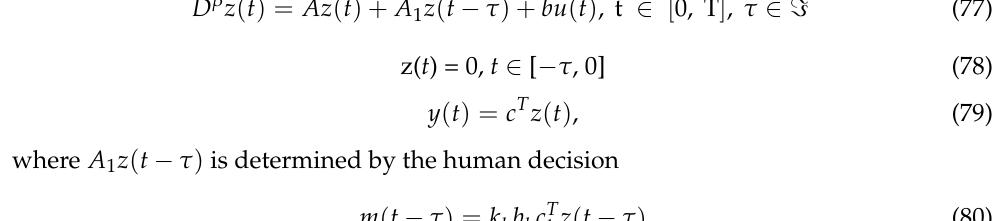
Figure 4. Motion trajectories for FOLS model.